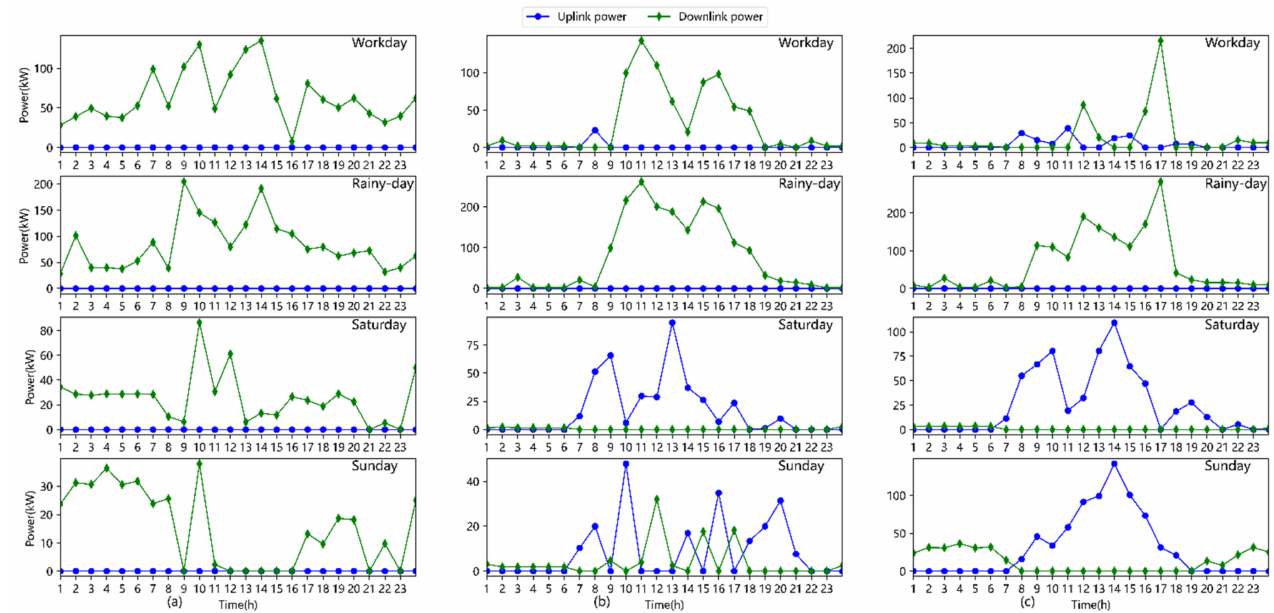
Figure 9. Uplink and downlink power of different transformers throughout workdays, rainy days, Saturdays, and Sundays. ( a ) Uplink and downlink power of transformer1; ( b ) uplink and downlink power of transformer2; ( c ) uplink and downlink power of